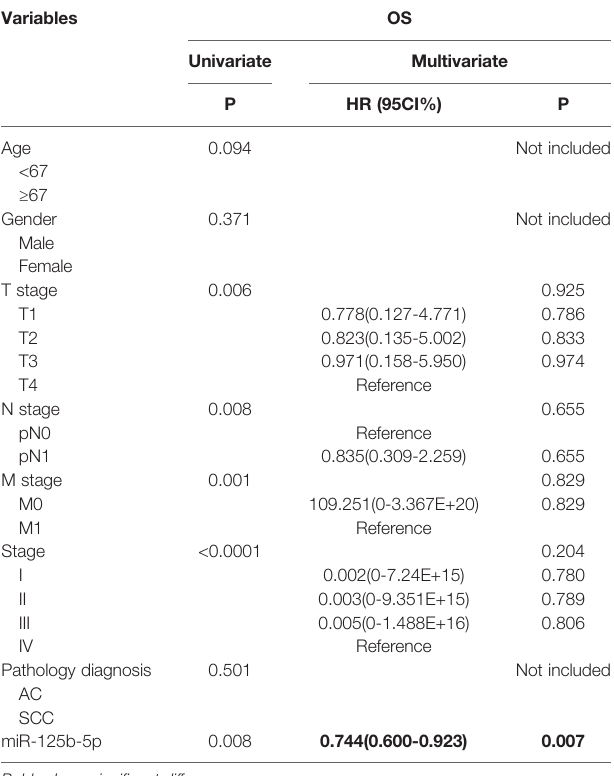
TABLE 4 | The in fl uence of different variables on OS for 864 patients with NSCLC analyzed by Cox proportional hazard model. Variables